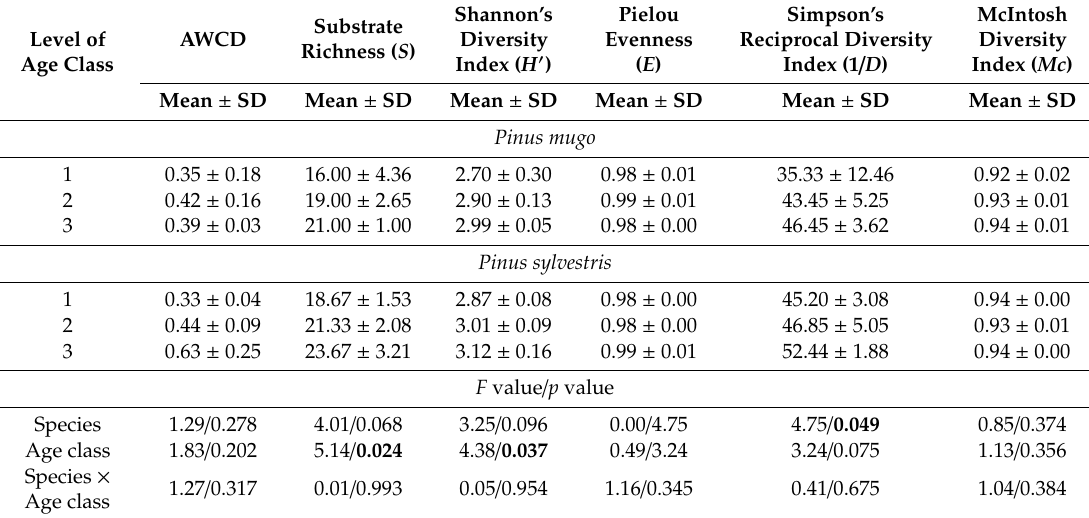
Table 1. Mean indices ( ± SD) of the metabolic activity of microorganisms in mineral soil (at 0–10 cm depth) at di ff erent growth sites. (Two-way ANOVA test, bold numbers show significant di ff erences, n =